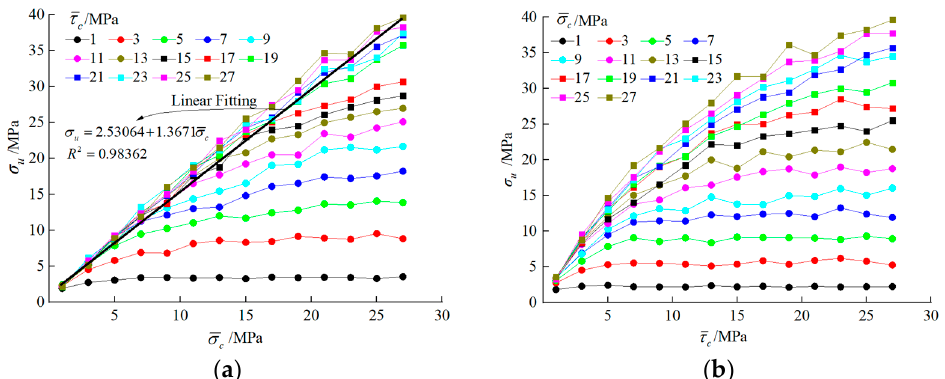
Figure 2. Effects of bond strength on peak strength: ( a ) tensile bond strength; ( b ) shear bond strength.